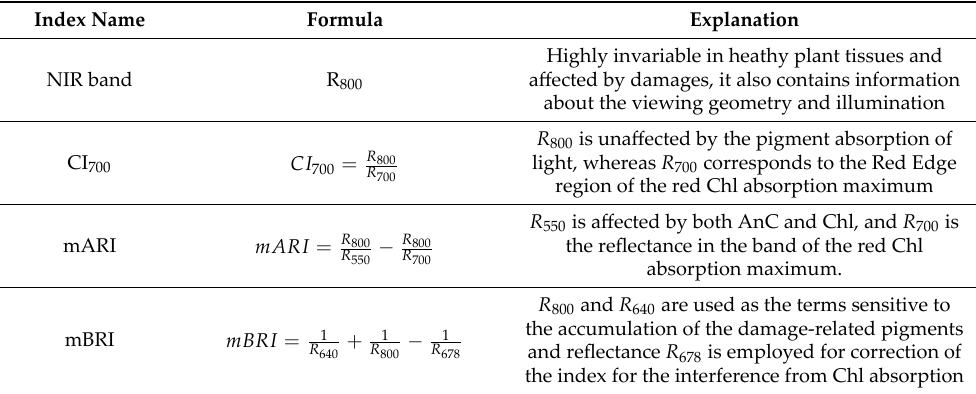
Table 1. Vegetation indices used as feature